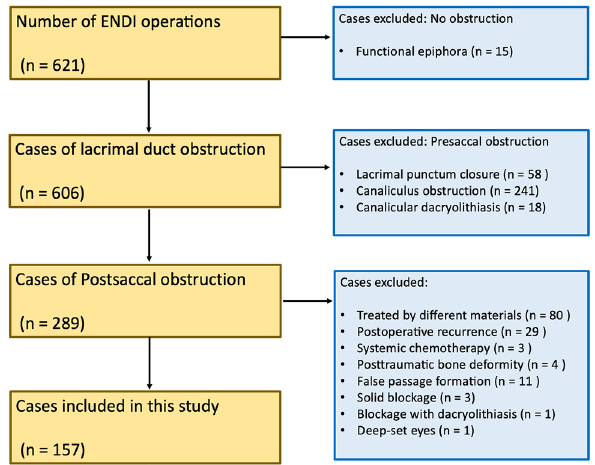
Figure 1. Flow diagram for the included cases in this study. Among the 621 ENDI operations, 15 cases had no obstruction, 317 cases had presaccal obstruction, and 289 cases had postsaccal obstruction. Of the 289 ENDI operations performed for postsaccal obstruction, we identified 16 cases of surgical failure. Of these, 11 were due to false passage formation, 3 were due to solid blockage, 1 was a blockage due to dacryolithiasis, and 1 was due to deep-set eyes. Abbreviation: ENDI, endoscopic-assisted nasolacrimal duct